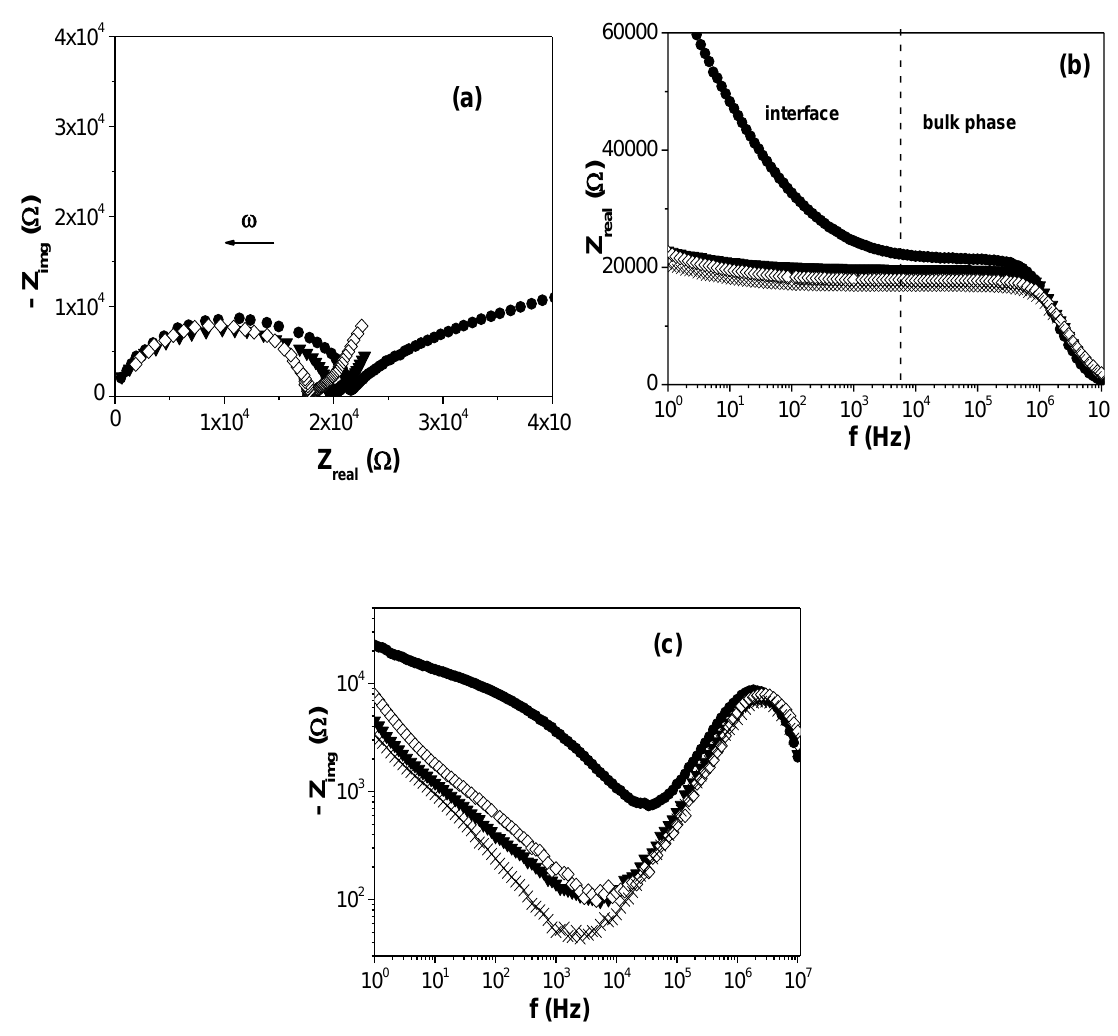
Figure 7. Impedance curves for the electrode/0.002 M NaCl solution/NPAS/0.002 M NaCl solution/electrode system. Nyquist plot (a); Bode plots: (b) and (c). NPAS-Sf (●), NPAS-Ph ( ▼ ), and NPAS-And (◊). ω = 2πf. Table 5. Values determined for the electrical resistance and capacitance of the three 0.002 M NaCl solution/sample (s/s) systems.